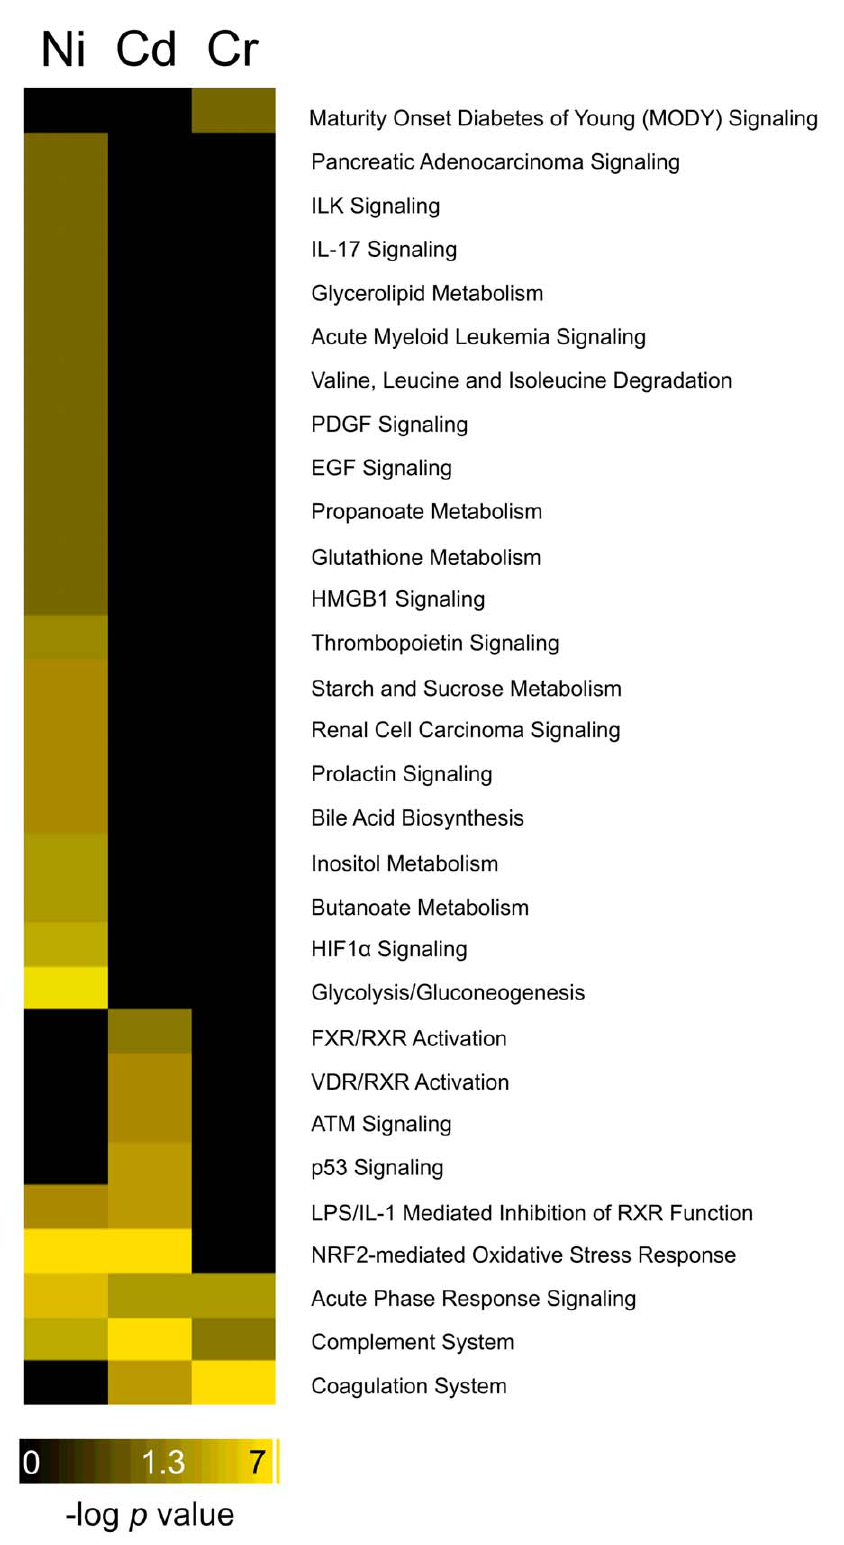
Figure 3. Canonical pathways associated with differentially expressed genes. IPA canonical pathways are enriched by the genes differentially expressed by exposure to nickel, chromium, and cadmium. While overall mechanisms of the three metals are similar, unique and common pathways are identified. The values are presented as the –log of the p-value.